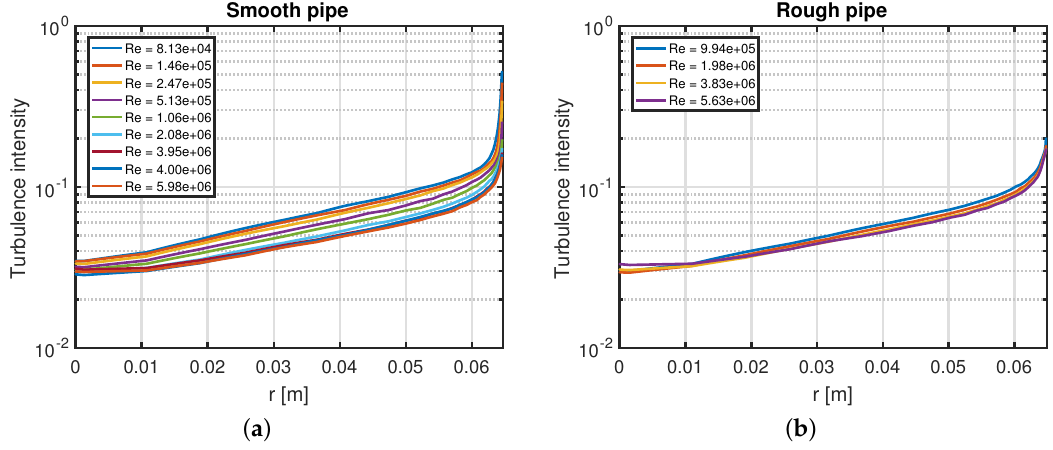
Figure 1. Turbulence intensity as a function of pipe radius, ( a ): smooth pipe; ( b ): rough